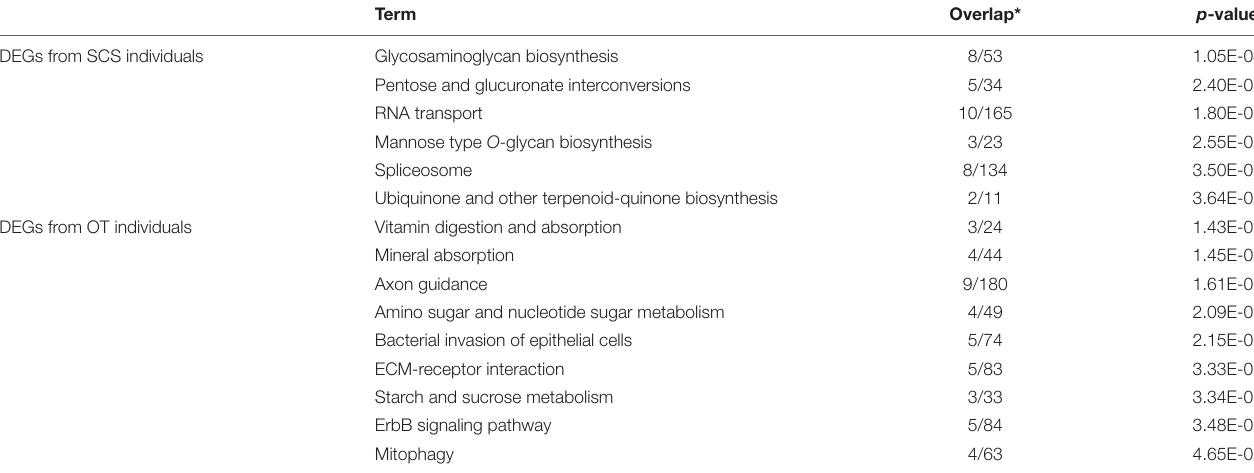
FIGURE 2 | Heatmap and hierarchical clustering analysis of 29 DEGs between the SCS and the OT. The color code represents the gene expression level based on the Log-transformed values. Red color indicates higher expression, whereas blue color indicates lower expression. TABLE 1 | KEGG enrichment analysis of all DEGs between S. crosnieri individuals from the SCS and those from the OT. Term Overlap* p